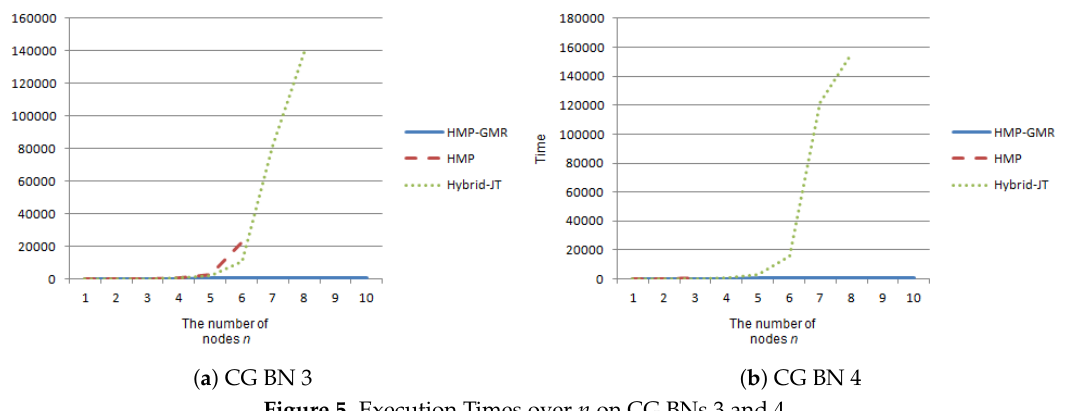
Figure 5. Execution Times over n on CG BNs 3 and